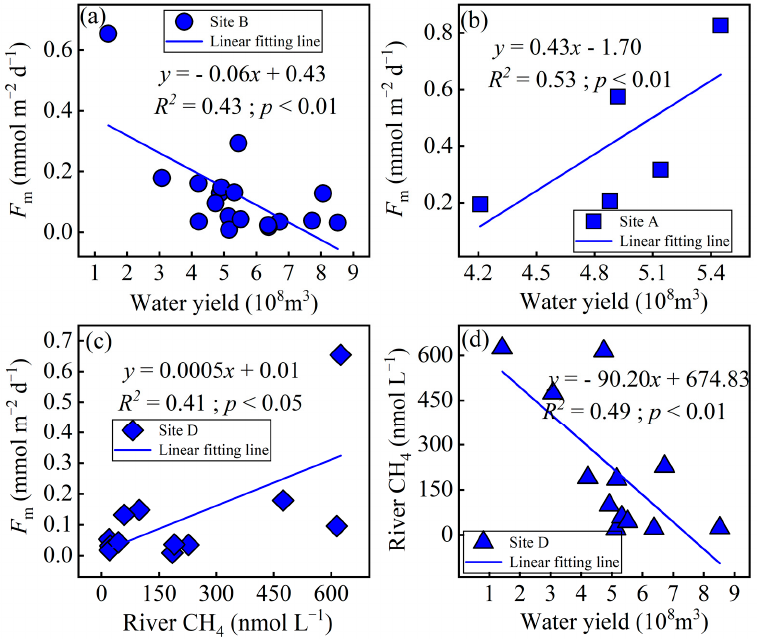
Figure 9. Correlations of seasonal CH 4 flux of Site A and Site B against inflowing water yield ( a , b ), correlation between the seasonal flux at Site B and the concentration of dissolved CH 4 in Dapu River ( c ), and correlation of dissolved CH 4 concentration of inflowing river (Dapu River) against water yield ( d ).